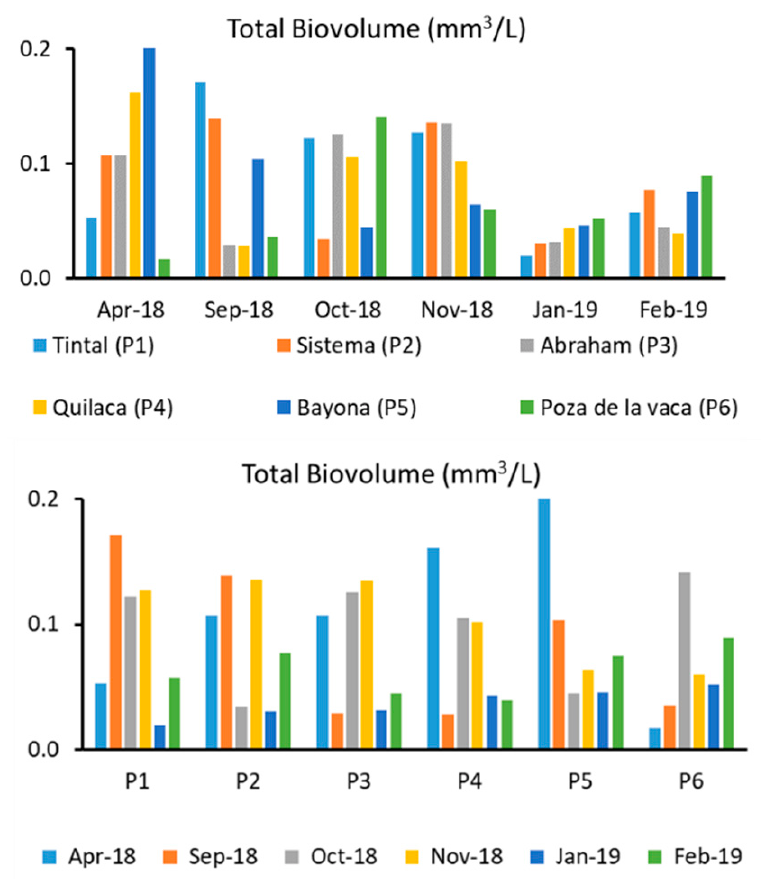
Figure 4. Biovolume of microalgae and cyanobacteria (MIC) estimated for the six sites of the Estero del Padre Ramos over the sampling period (upper graph) and temporal dynamics of biovolume in each site (bottom graph).